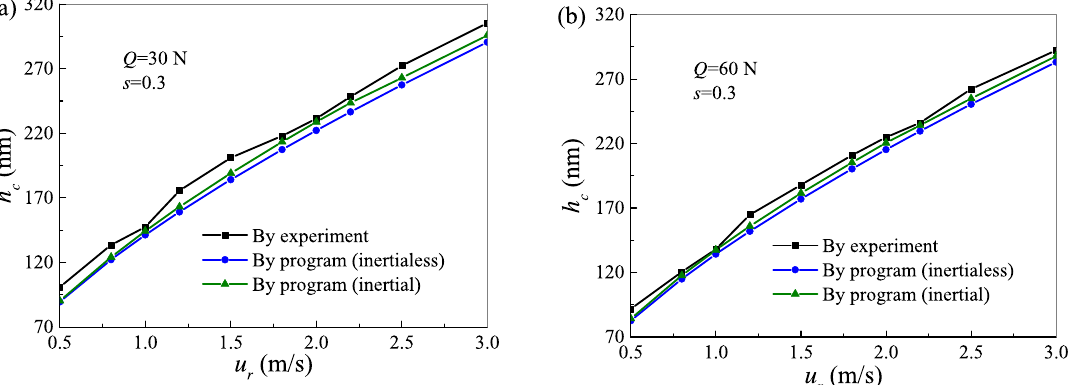
Fig. 4. Comparison of central fi lm thickness by experiment and program at varied entrainment velocity under applied loads of: (a) 30N and (b) 60N.